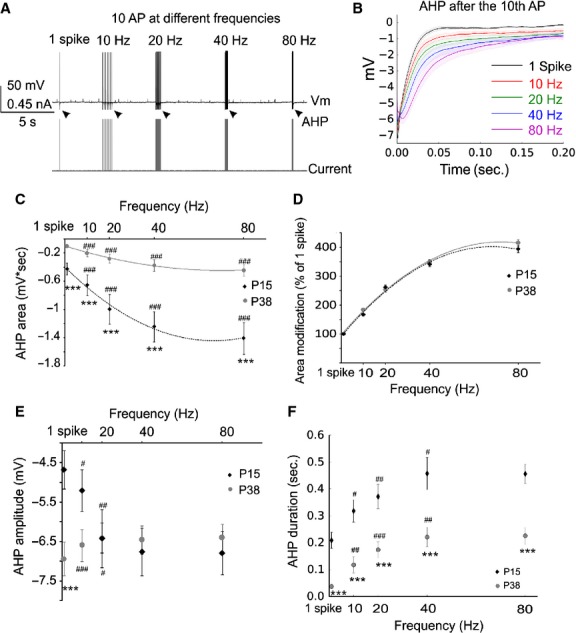
The global MC AHP increases with the firing frequency. (A) Schematic representation of the stimulating protocol used to elicit MC firing at different frequencies. Black arrows indicate the AHPs following the last spike of each train that were used for analysis. (B) Average traces of the AHP following the last spike of the train at different frequencies (from the P38 group). Shadow areas represent the SEM. (C) The AHP area is significantly larger in MC from the P15 group and increases with the MC firing frequency for all the frequencies tested at both ages. (D) Normalization of the AHP area to that produced by 1 spike show a similar frequency-dependent increase in the AHP between the two age groups. The AHP amplitude decreases with MC firing frequency, in the range from 1 spike – 20 Hz, in MC from older rats but increase in the same frequency range in MC from the P15 group. (F) AHP duration is also larger in the P15 group and increases with the firing frequency in the range 1-spike 40 Hz. #Significantly differs from the previous frequency. *Significantly difference between the groups.*P < 0.05 **P < 0.01; ***P < 0.001.